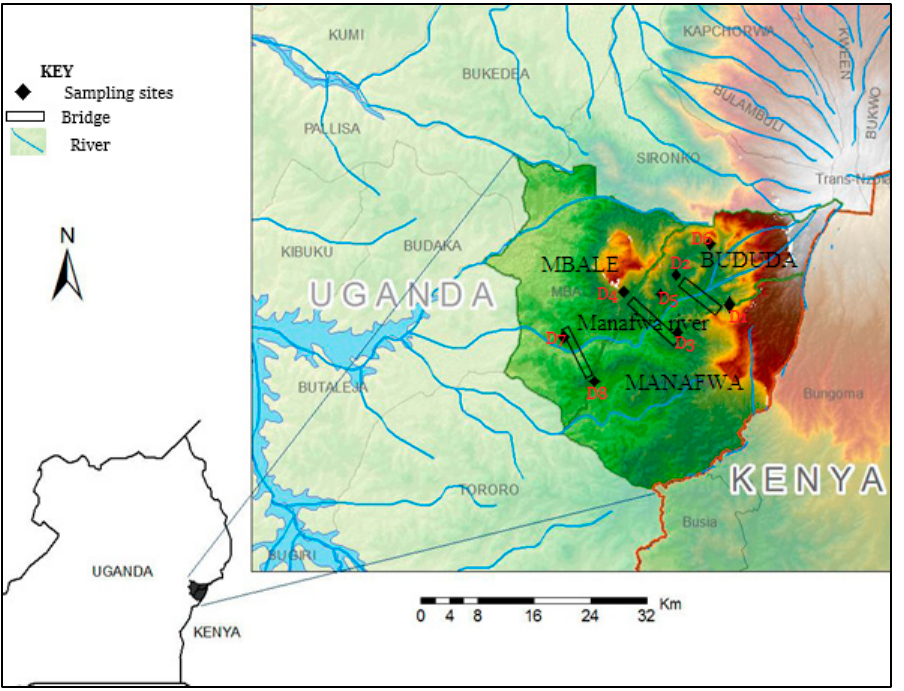
Figure 1. Map of Eastern Uganda showing where dust samples were taken. Further details on the description of the sampling sites (D1 to D8) are given in Table 1. Table 1. Sites where dust samples were obtained in Eastern Uganda.